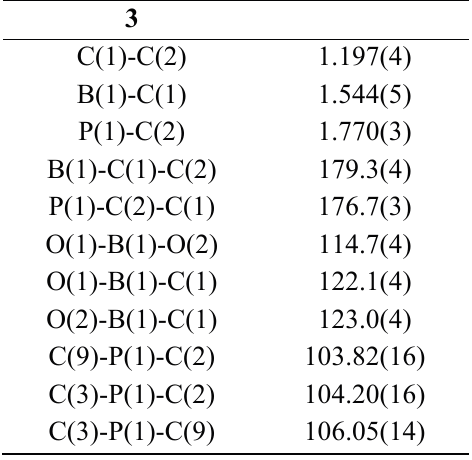
Table 2. Selected bond lengths ( Ǻ ) and angles (°) for 3